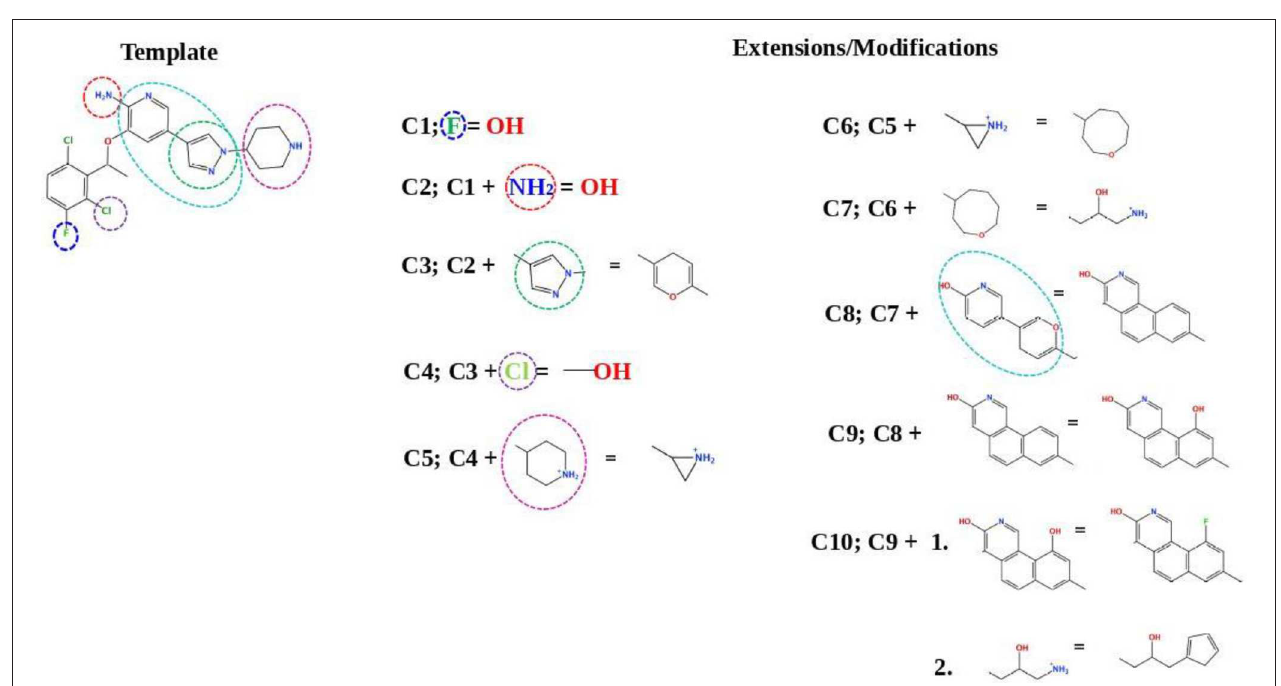
FIGURE 7 | A schematic representation of the crizotinib modifications. The upper-left part is a template that undergoes modifications (indicated by dashed circles ). The upper-right and lower-right/left parts are extensions/modifications of the template.